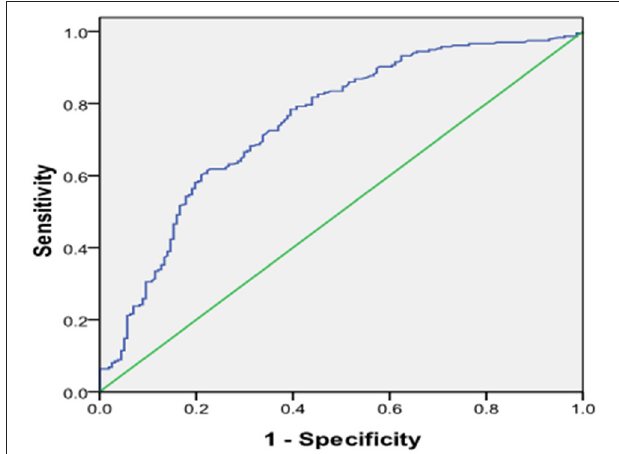
FIGURE 1 | Receiver operating characteristic (ROC) plot of serum level of galetcin-3 predicting presence of ACS. Area under the curve was 0.746, 95% CI (0.696–0.797), P < 0.001. When the cut-off value of galectin-3 was 3.93ng/ml, the sensitivity was 60% with specificity 79% for predicting the presence of